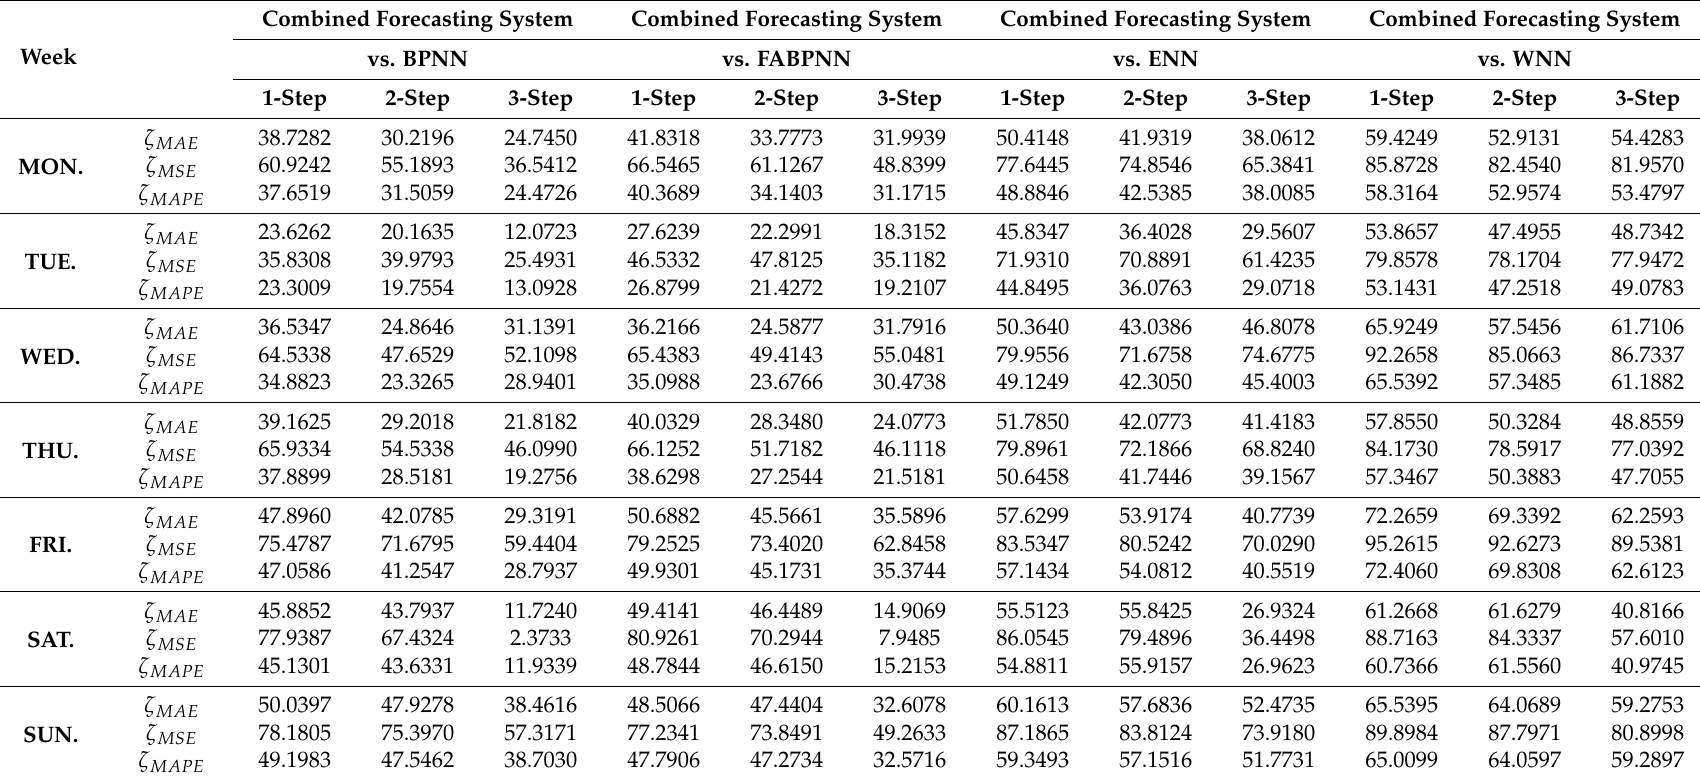
Table 8. Improvement percentages generated by the combined forecasting system from June